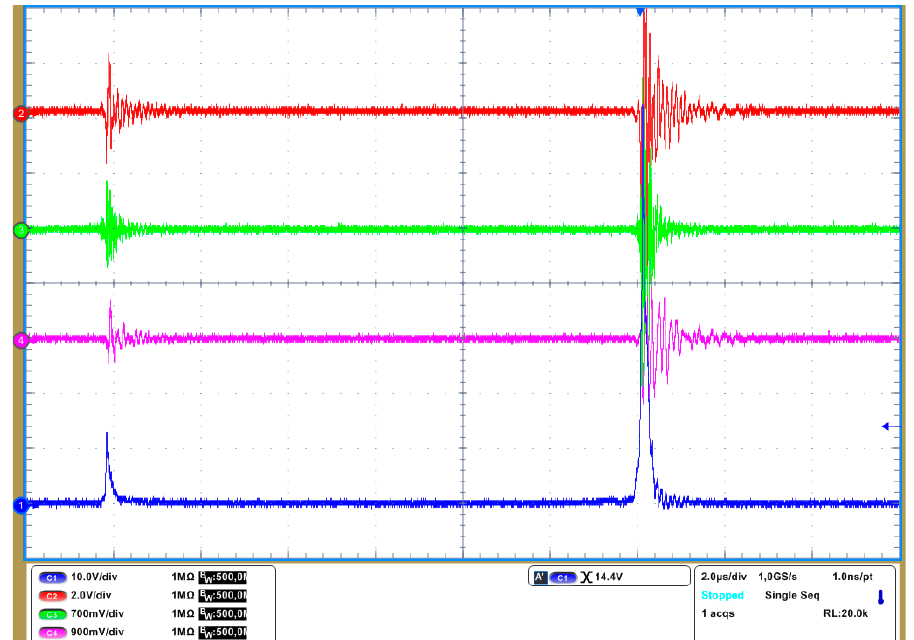
Figure 11. Characteristic oscillogram of the first and repeated discharge current pulse (blue signal) from the system of artificial thunderstorm cells of positive polarity with the participation of lower and upper groups of model hydrometeors and signals, registered by antennas A1-A3 (red, green and magenta signals resp.).